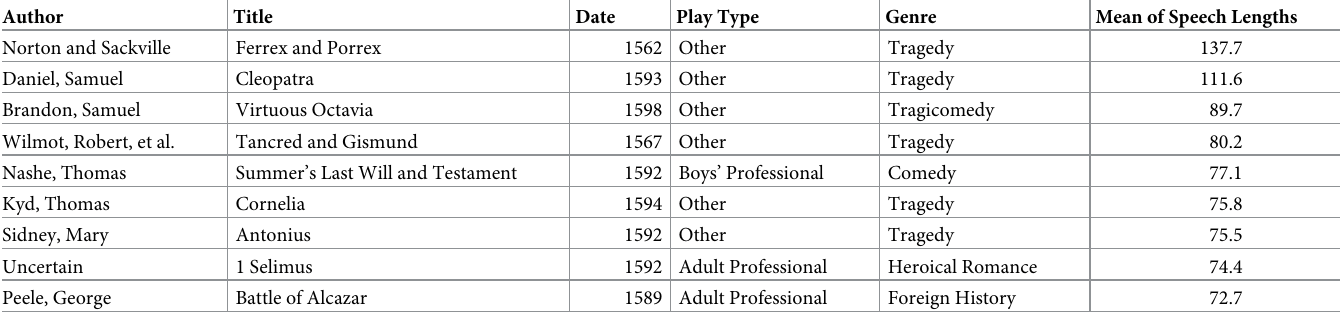
Table 4. Plays with mean speech lengths greater than